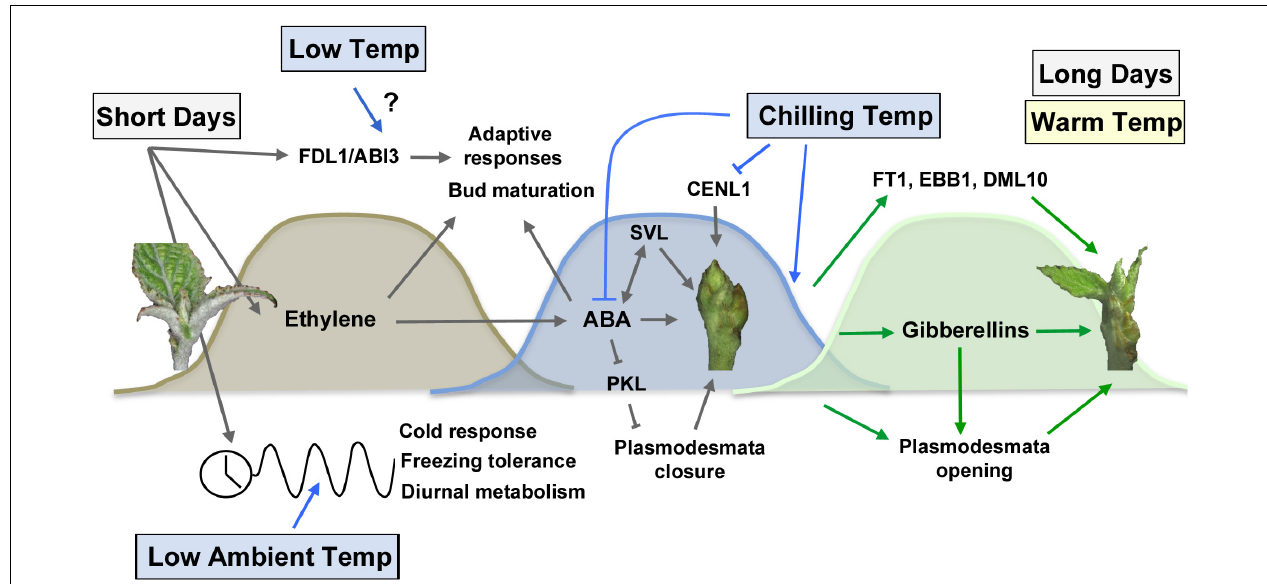
FIGURE 2 | Photoperiodic and temperature control of bud set, dormancy establishment and bud break. Short days promote bud set via activation of Flowering locus D1 ( FLD1 ) and Abscisic acid insensitive 3 ( ABI3 ) (Tylewicz et al., 2015), the ethylene and ABA pathways (Rohde et al., 2002; Ruonala et al., 2006) as well as the circadian clock pathway (Hoffman et al., 2010; Ibañez et al., 2010). The timing of bud set is sensitive to low ambient temperature, which alters the expression of the circadian pathway ( Figure 1 ). ABA plays an essential role in dormancy establishment by promoting plasmodesmata closure via PKL repression (Tylewicz et al., 2018) and activating SVL growth repressive gene (Singh et al., 2018). Increased exposure to chilling temperatures is necessary to the downregulation of ABA and degradation of growth repressors such as CENL1 (Karlberg et al., 2010; Mohamed et al., 2010; Tylewicz et al., 2018). Dormancy release increases gibberellin levels (Rinne et al., 2011), mediates plasmodesmata opening (Tylewicz et al., 2018) and activates bud break-promoting factors such as FT1 (Hsu et al., 2011; Rinne et al., 2011), EBB1 (Yordanov et al., 2014), and DML10 (Conde et al., 2017). Long days and warm temperatures restore shoot apical